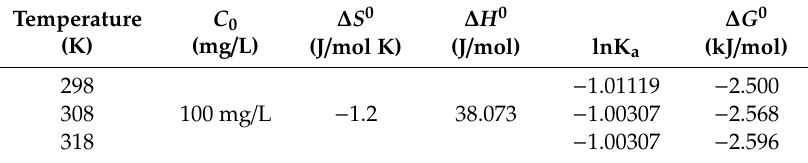
Table 7. Thermodynamic parameters for the adsorption system AB92-Nd 2 O 3